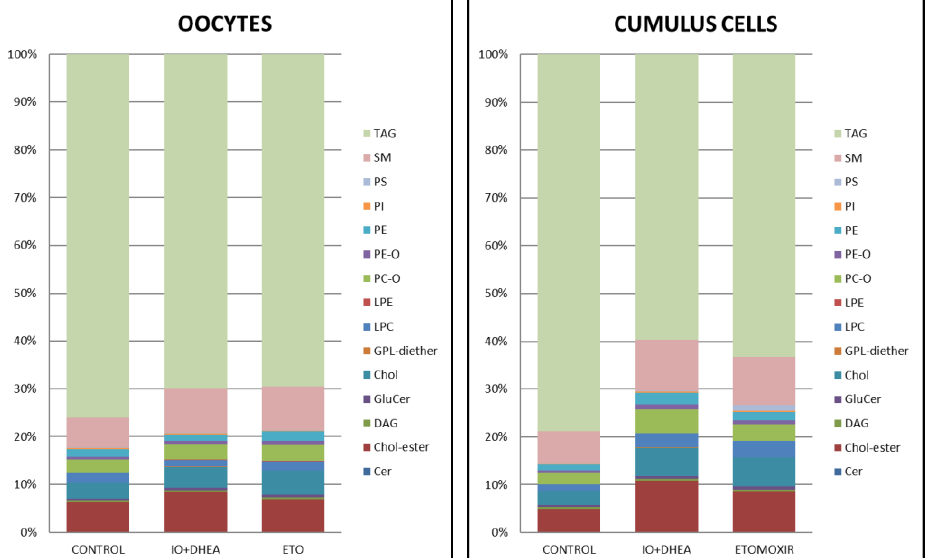
Figure 9. The distribution of lipid classes regarding experimental group (CON vs. IO+DHEA vs. ETO) or cell type (OOCYTES vs. CUMULUS CELLS). Cer (ceramides); Chol-ester (cholesterylester); DAG (diacylglycerols); GluCer (glucosylceramide); Chol (cholfragment); LPC (lysoPhosphatidylcholine); LPE (lysoPhosphatidylethanolamine); PC-O (phosphatidylcholineether); PE-O (phosphatidylethanolamineether); PE (phosphatidylethanolamine); PI (phosphatidylinositol); PS (phosphatidylserine); SM (sphingomyelin); TAG (triacylglycerol).